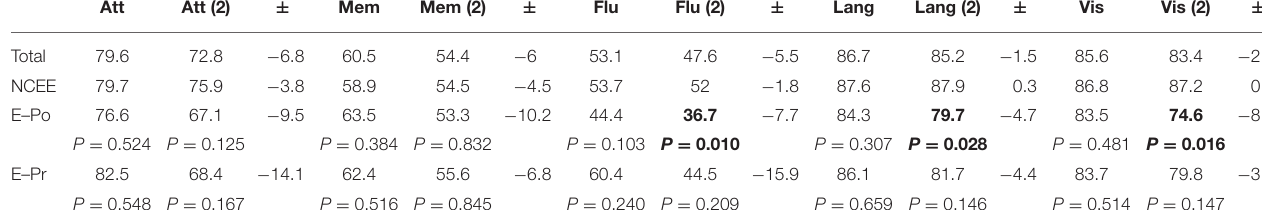
TABLE 4 | ACE-III domain scores in AD participants at PrESIDe baseline and 12-month follow-up, bold figures indicate significant difference ( p < 0.05) when compared to NCEE group. Att